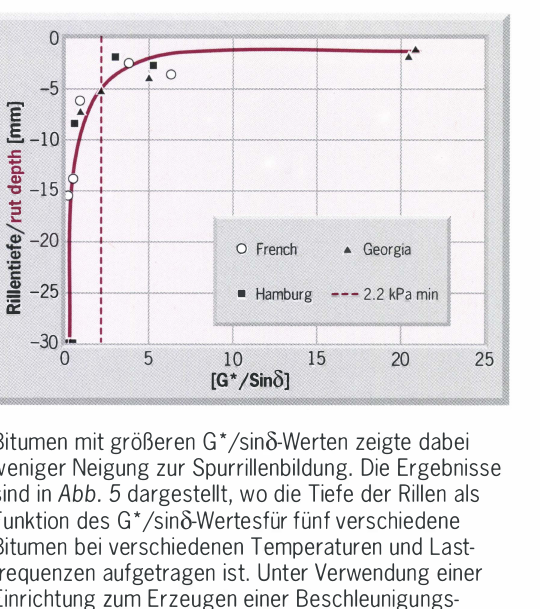
Fig. 5: Laboratory Validation of Superpave Rutting Parameter G*/Sin8, plotted using Data from [11]